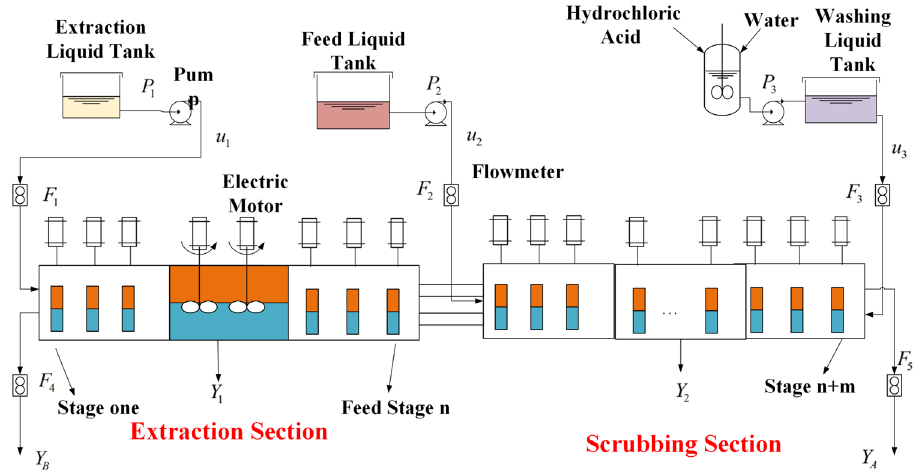
Figure 4. Structure of rare earth extraction